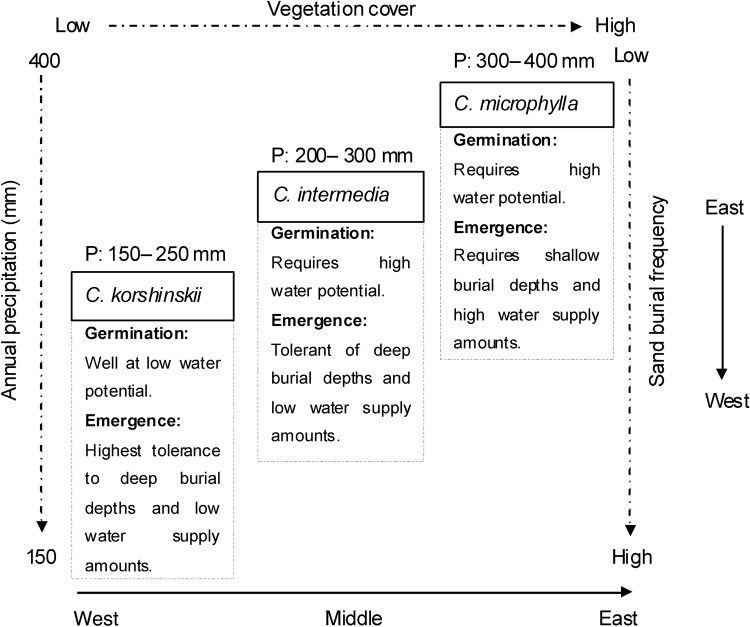
Conceptual model of the distribution of three Caragana species along the precipitation (P) gradient.